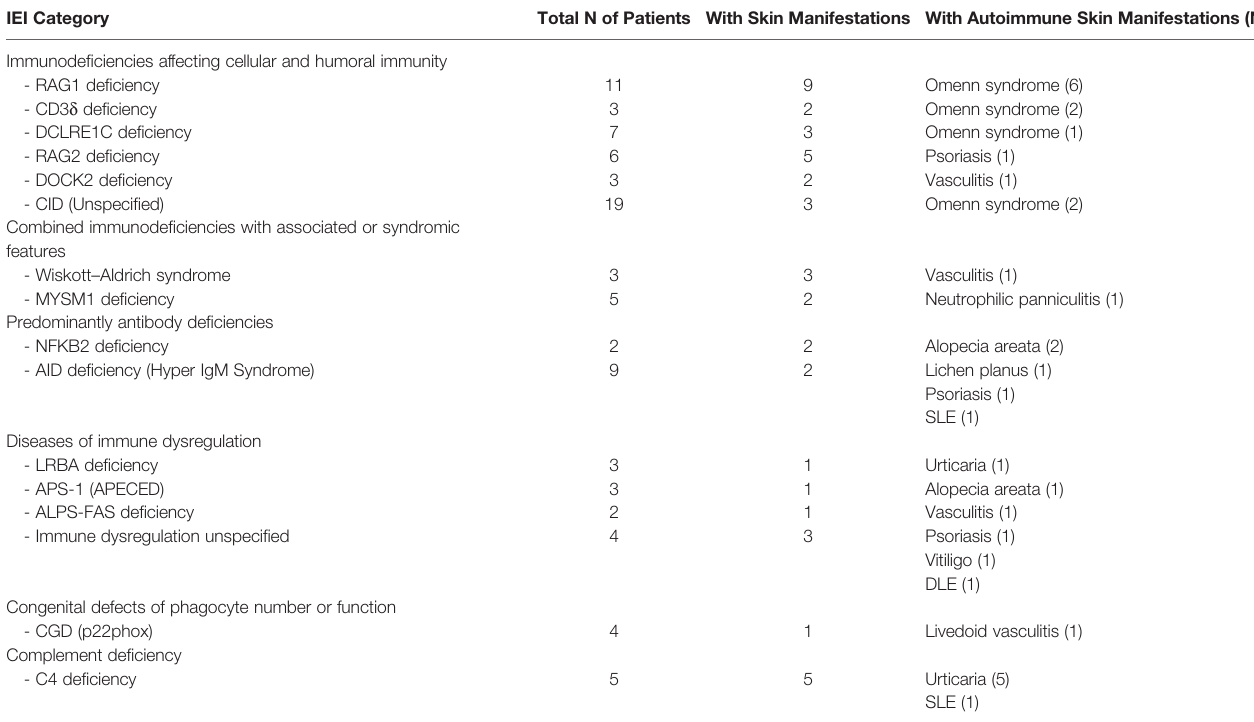
TABLE 6 | Autoimmune skin associations with IEI among children registered in the KNPIDR. IEI Category